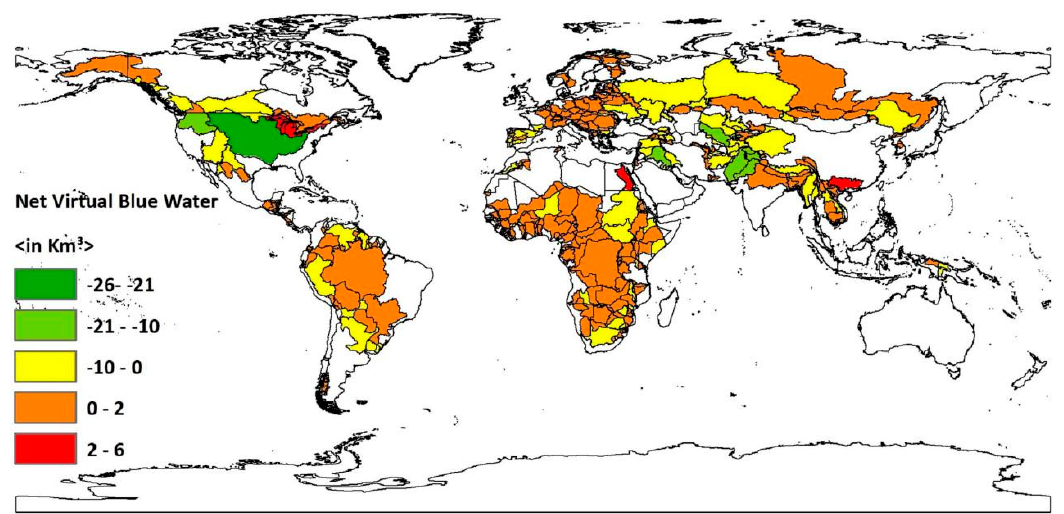
Figure 3. Net blue virtual water balance for global transboundary river basins’ country-basin units. Period: 1996–2005. This map was generated with ArcGIS 10.2 for desktop from Environmental Systems Research Institute (ESRI), Redlands, CA, USA [28].